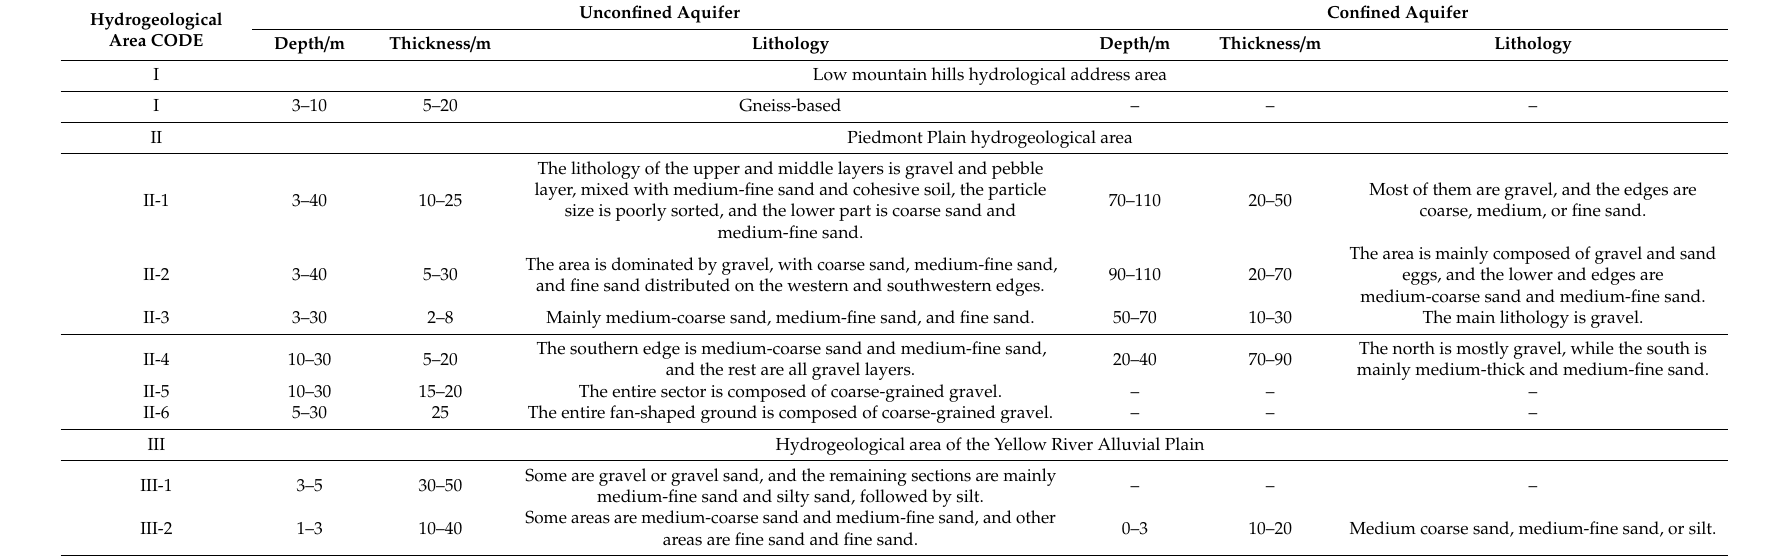
Table 2. Hydrogeological area and